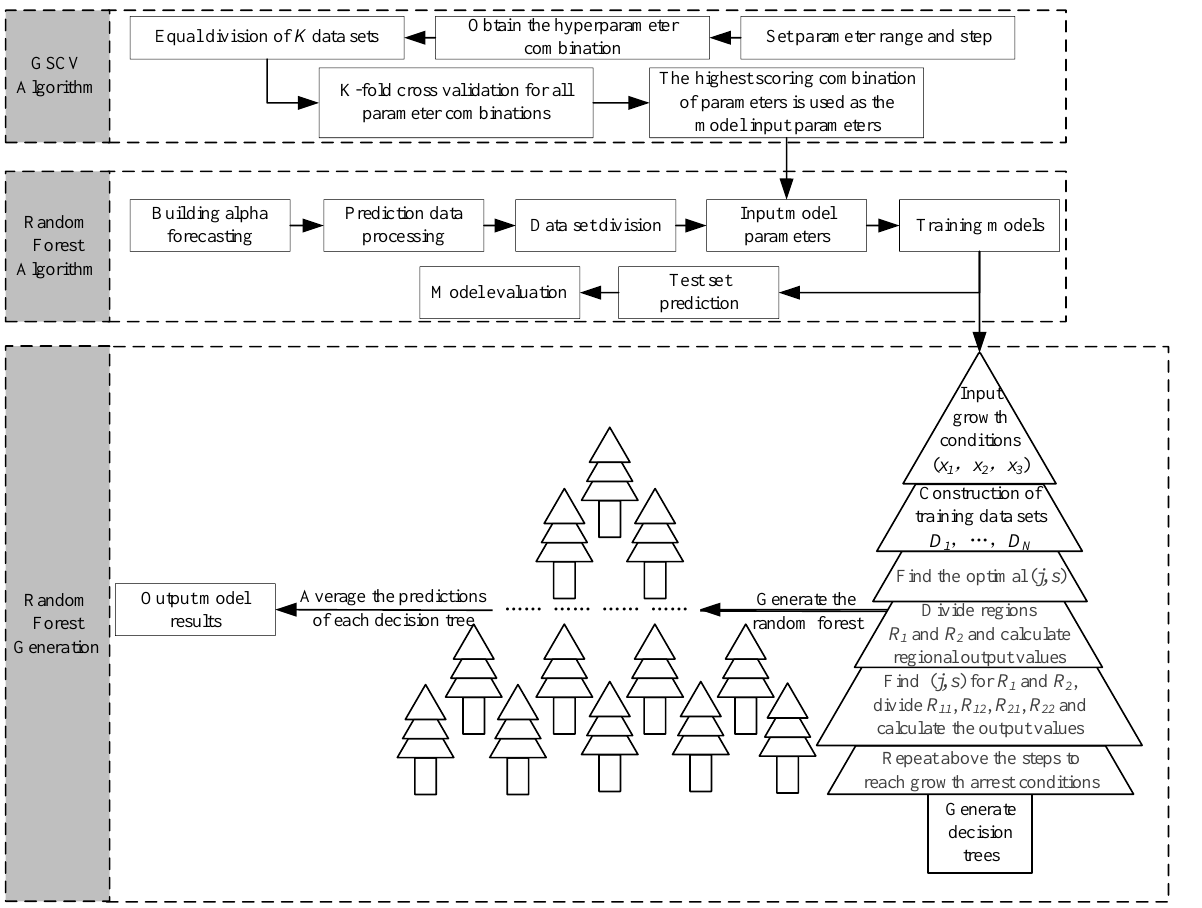
Figure 4. GSCV-RF model prediction process.